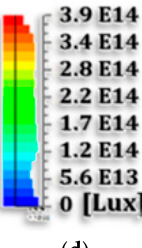
Figure 9. LED cone. ( a ) LED cone with internal conical emitting layer; ( b ) LED cone with multiple sub-cone emitting layers.